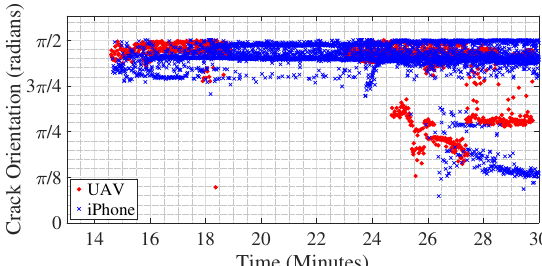
Figure 13. Dominant orientation of individual cracks in radians varying over time for video recorded using both iPhone and